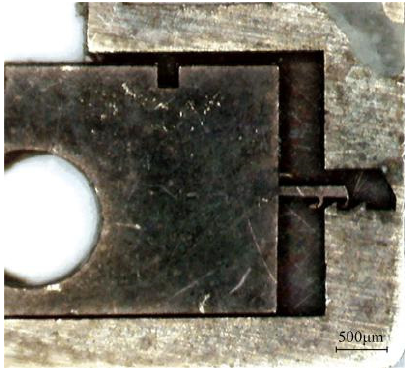
Figure 25. Test results of prototype #5.